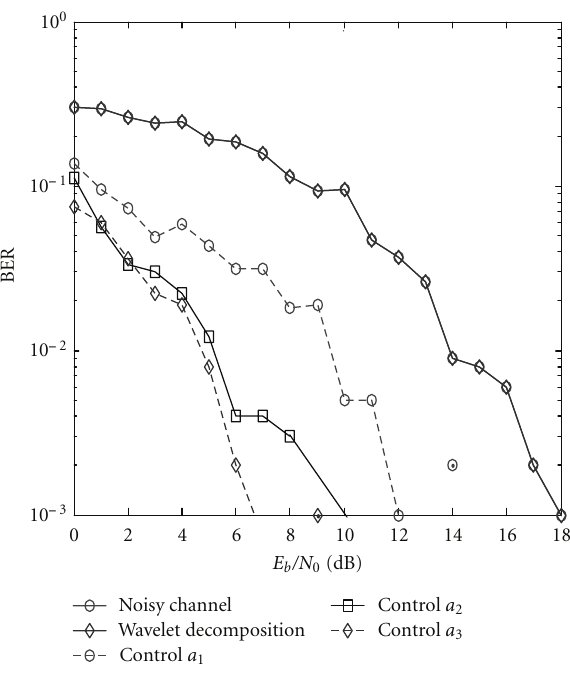
Figure 11: BER performance through AWGN